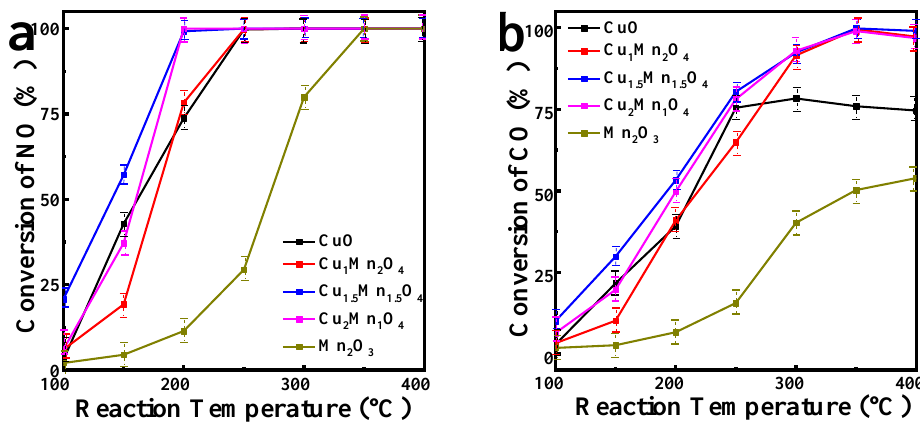
Figure 7. ( a ) NO conversion and ( b ) CO conversion of all the catalysts in the